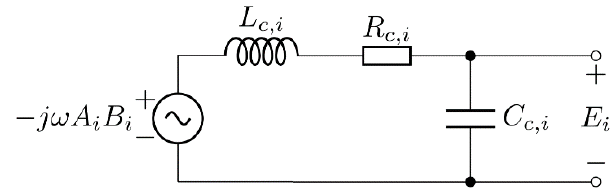
Figure 16. Equivalent circuit representation of the search coil.